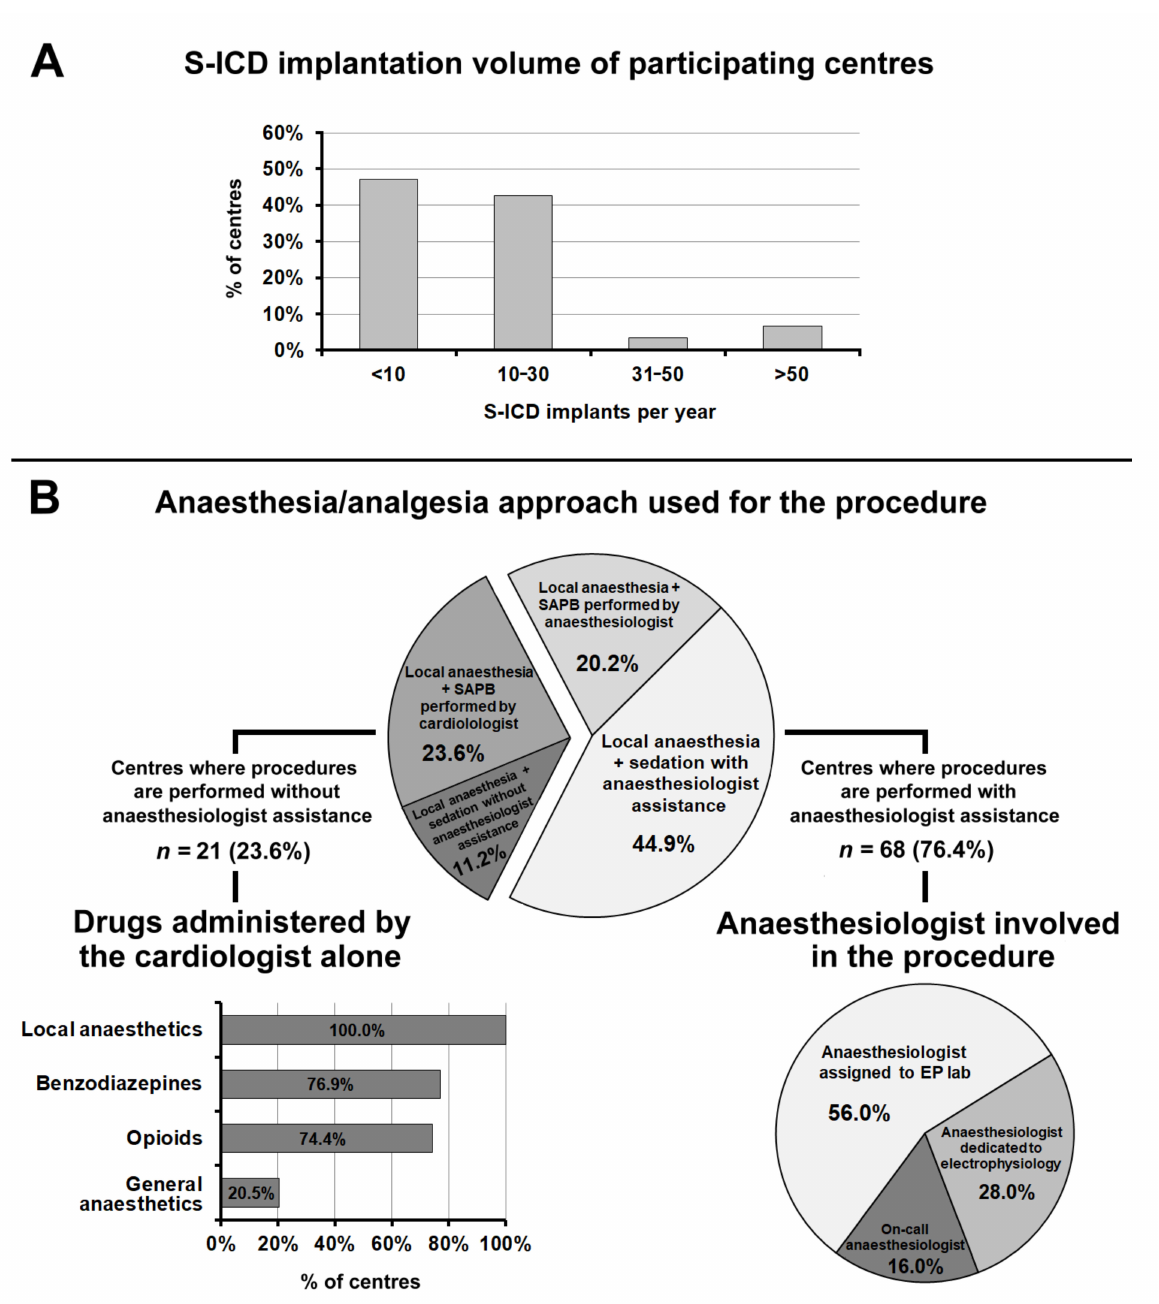
Figure 3. ( Panel A ): Subcutaneous implantable cardioverter-defibrillator implantation volume of participating centres. ( Panel B ): Anaesthesia/analgesia approach used for the procedure. Abbreviations used in the figure. S-ICD: subcutaneous implantable cardioverter-defibrillator; EP lab: electrophysiology